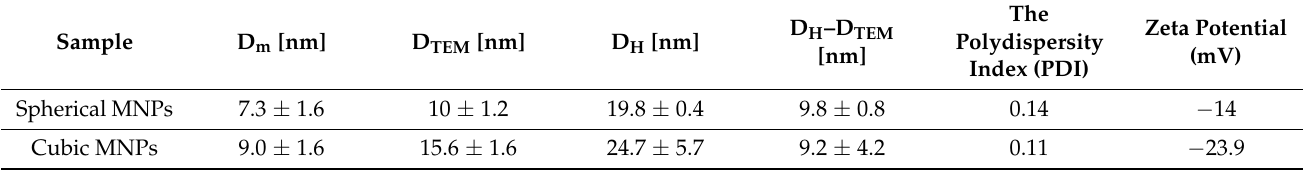
Table 2. MNP size is determined by magnetization, TEM and DLS